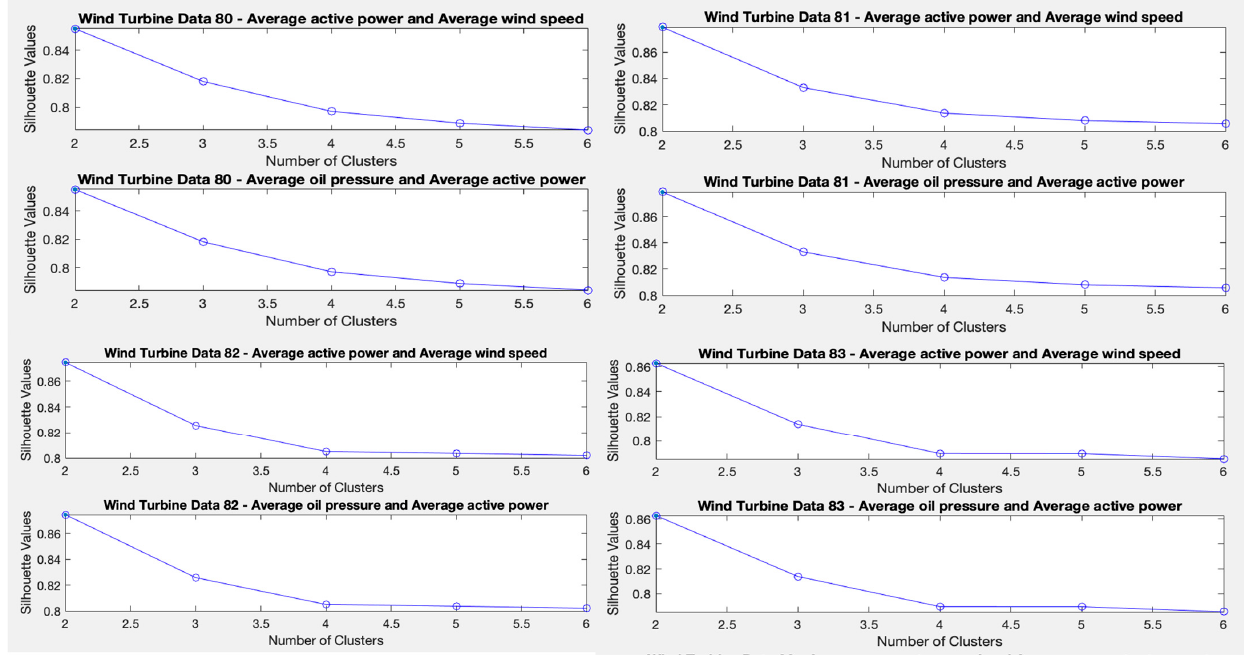
Figure 3. Ideal number of clusters for the four wind turbines.